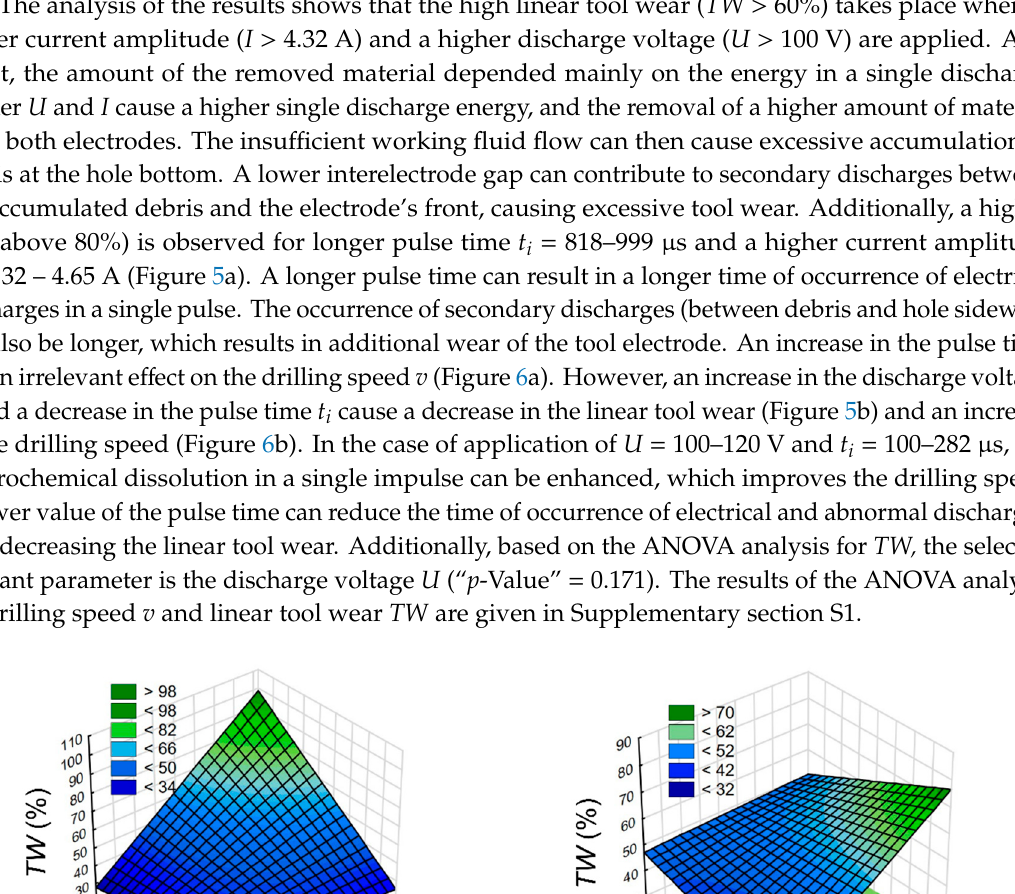
Figure 6. Relationship between the drilling speed v and the pulse time t i and ( a ) current amplitude I , U = 100 V and ( b ) discharge voltage amplitude U , I = 3.83